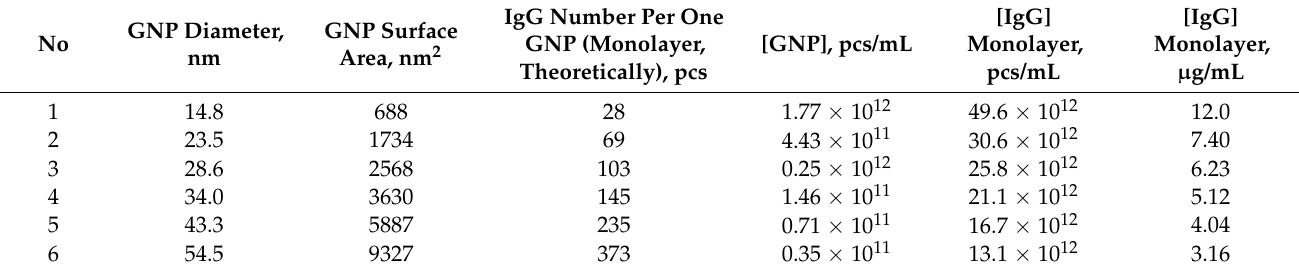
Table 2. Parameters of GNPs and the calculated amounts of IgG added to fill the